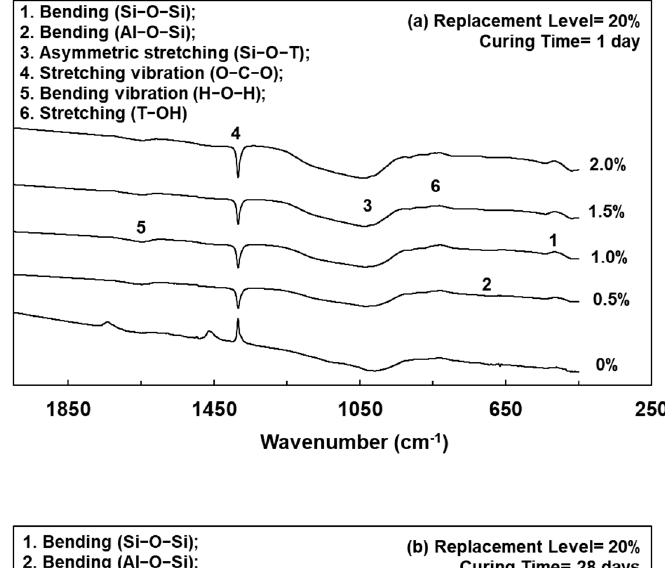
Figure 4. FTIR spectrums of lightweight FGPs. (Replacement level = 10%). (a) 1day; (b) 28 days